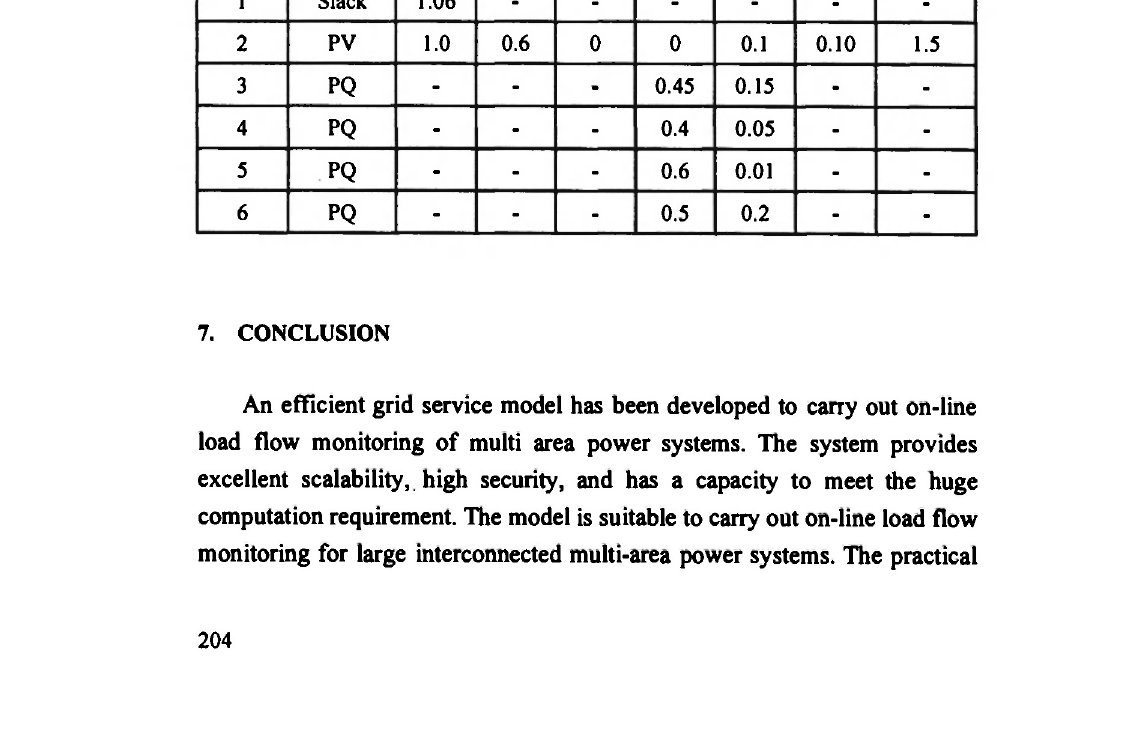
Table 2: Bus data